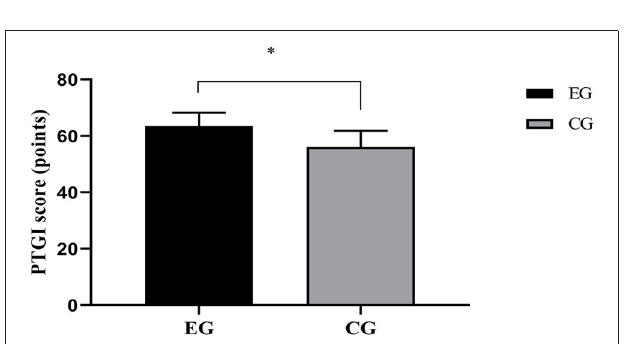
FIGURE 2 | Comparison of PTGI scores [Mean ± SD]. The abscissa represented EG and CG, and the ordinate represented the PTGI score (points). The PTGI scores of EG and CG were (63.42 ± 4.78) and (56.18 ± 5.69), respectively. *indicated a notable difference in the PTGI scores between the two groups ( t = 6.536, P <